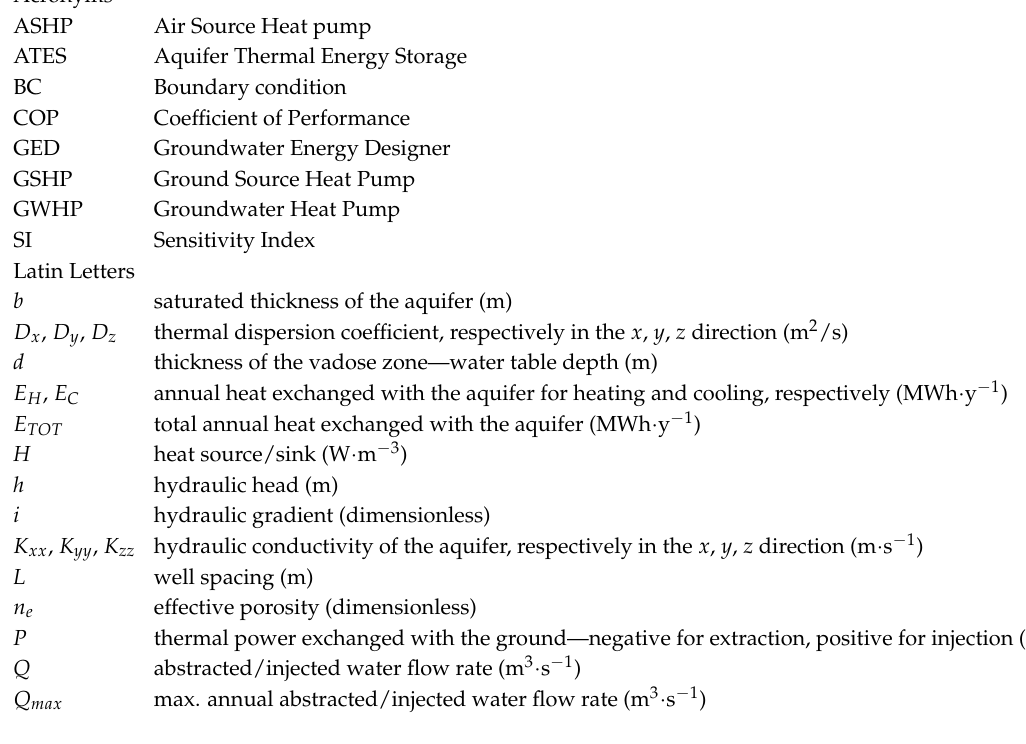
Figure S1: Mesh adopted in the analysis, abstraction and injection wells in red (252k nodes), Figure S2: Mesh convergence study results: thermal plume length (a) and width (b) after 50 years, for different levels of mesh refinement, Table S1: Length of the thermal plume after 10 years and 50 years of operation, calculated with different methods—parametric study, Table S2: Width of the thermal plume after 10 years and 50 years of operation, calculated with different methods—parametric